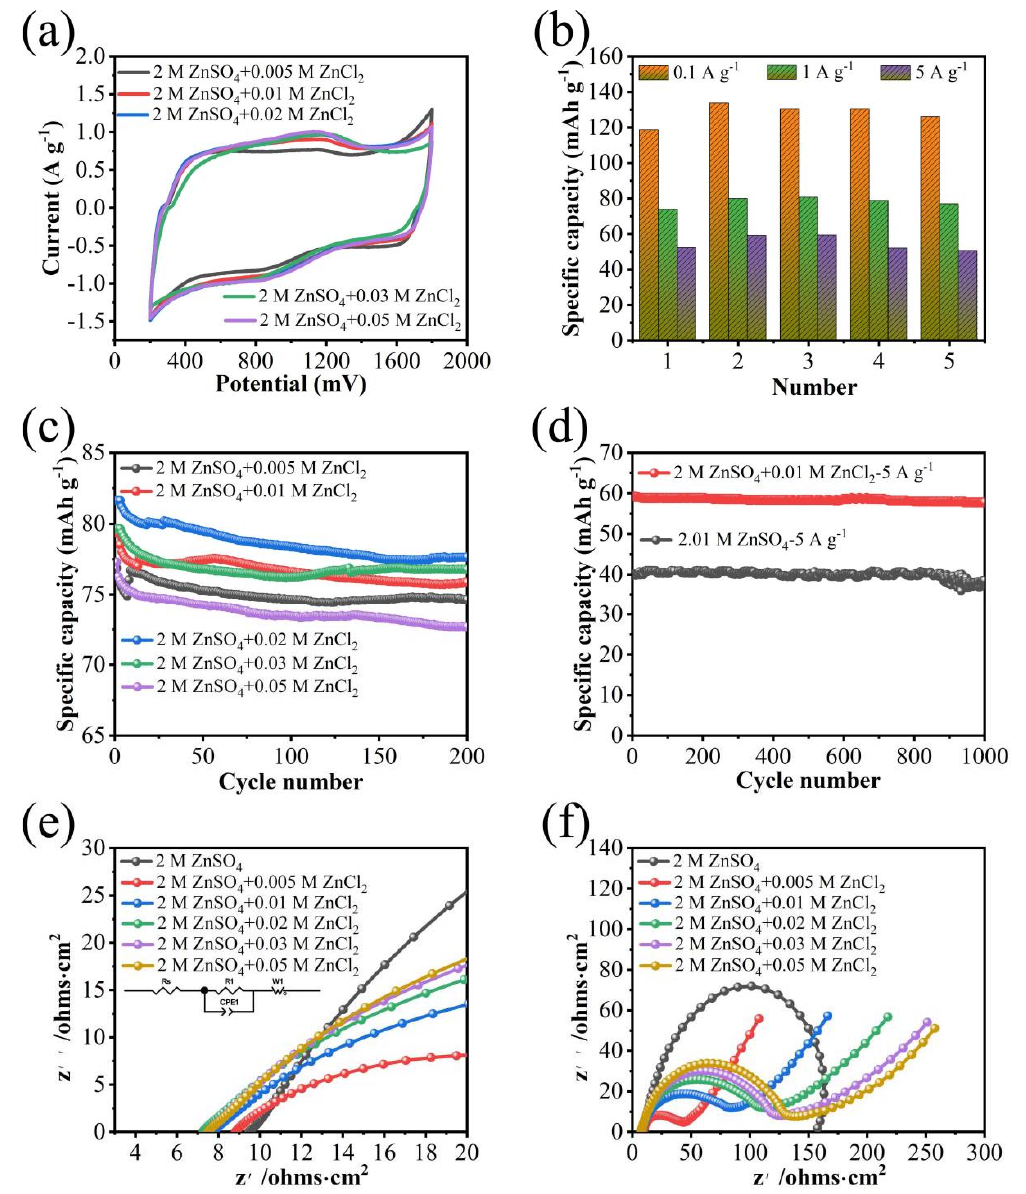
Figure 4. ( a ) Comparison of five CV curves (5 mV s − 1 ); ( b ) Numbers 1, 2, 3, 4, and 5 are 2 M ZnSO 4 + 0.005 M ZnCl 2 , 2 M ZnSO 4 + 0.01 M ZnCl 2 , 2 M ZnSO 4 + 0.02 M ZnCl 2 , 2 M ZnSO 4 + 0.03 M ZnCl 2 , and 2 M ZnSO 4 + 0.05 M ZnCl 2 electrolytes, respectively; ( c ) Cycling performance (1 A g − 1 ) of hybrid anionic electrolytes; ( d ) Cycling performance (5 A g − 1 ) of electrolytes with the same Zn 2+ concentration; ( e ) Nyquist plot of hybrid anionic electrolyte in high-frequency region; ( f ) Nyquist plot of hybrid anionic electrolyte.